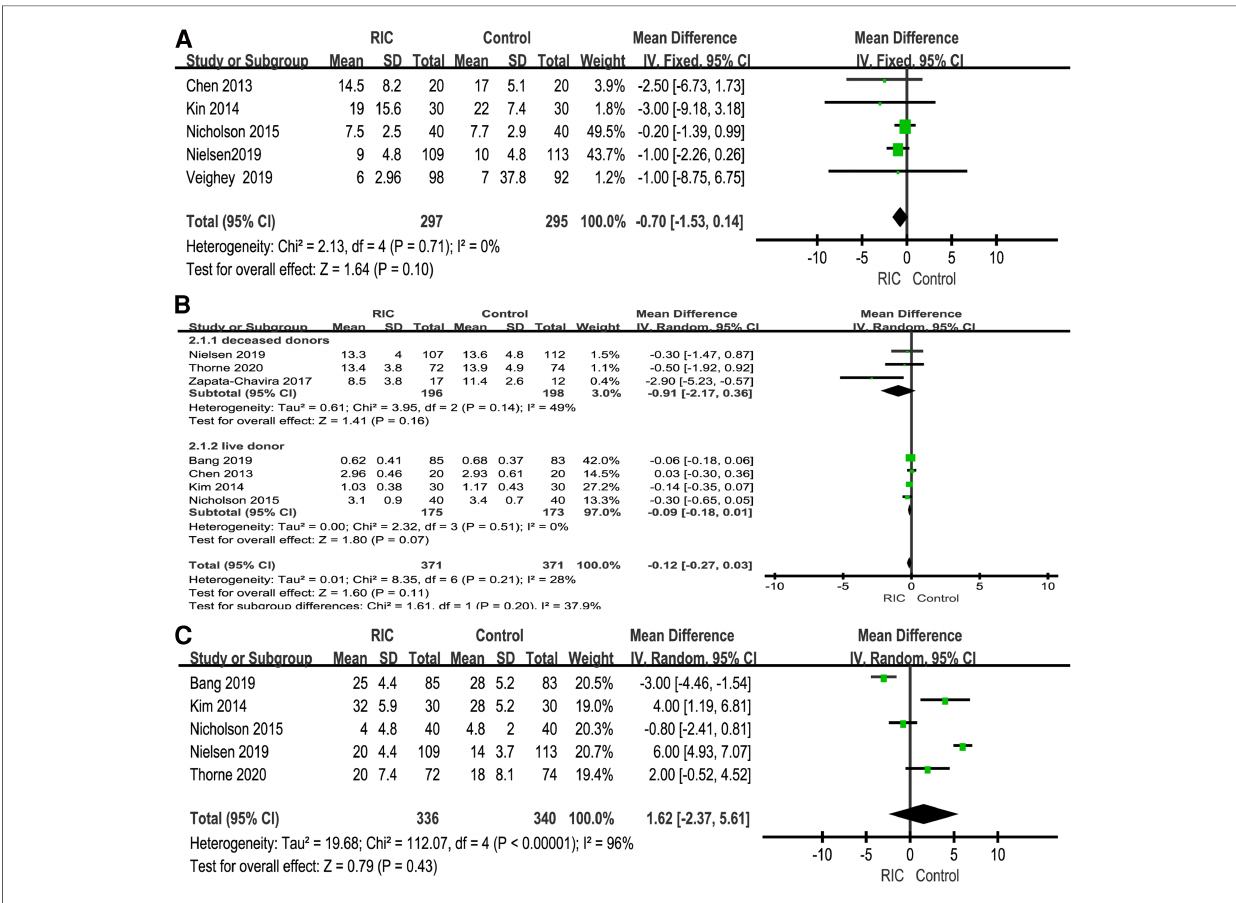
FIGURE 7 Forest plot with 95% con fi dence interval for length of hospital stay on kidney transplantation ( A ); meta-analysis of cold ischemic time ( B ) and warm ischemic time ( C ). RIC, remote ischemic